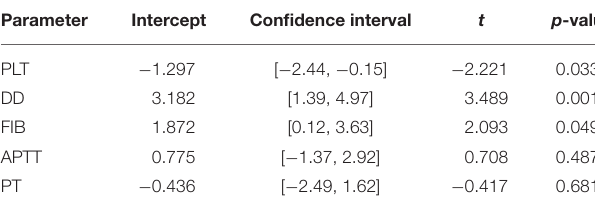
TABLE 4 | Egger’s test for publication